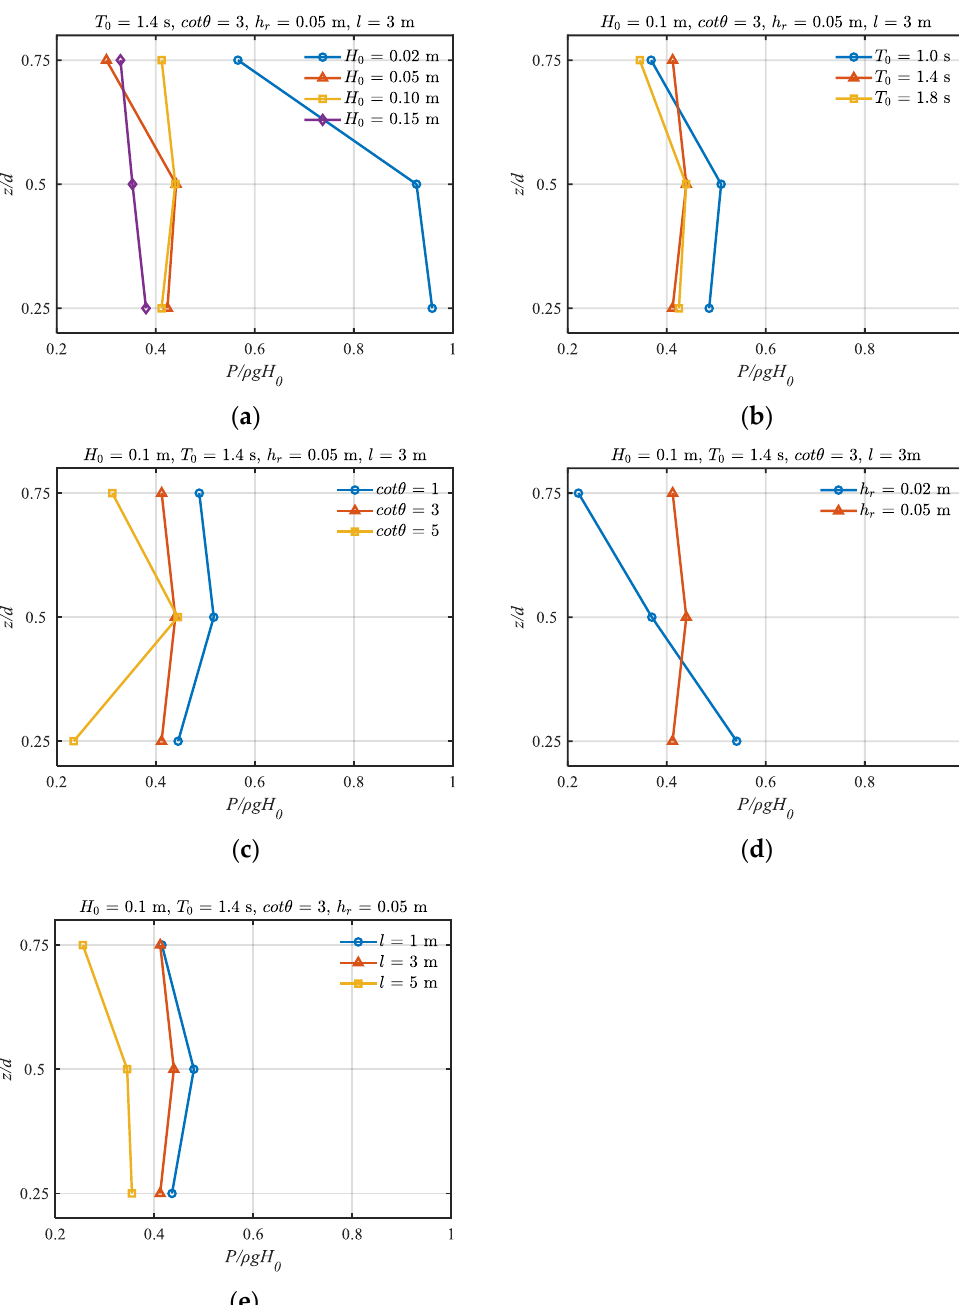
Figure 18. Regular wave peak pressure distribution along the seaward surface of sloped seawall for different cases: ( a ) H 0 ; ( b ) T 0 ; ( c ) cot θ ; ( d ) h r ; ( e ) l .